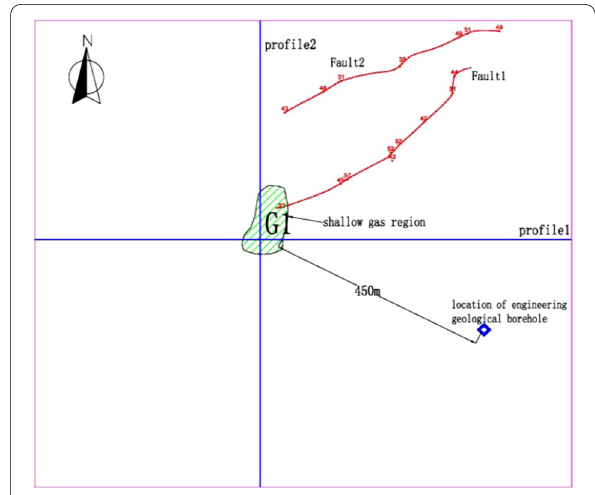
Fig. 12 Range of shallow gas